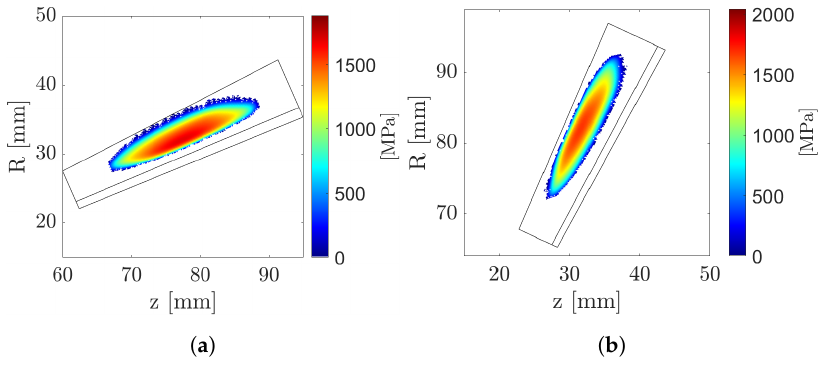
Figure 9. Initial contact patterns. ( a ) Pinion. ( b )